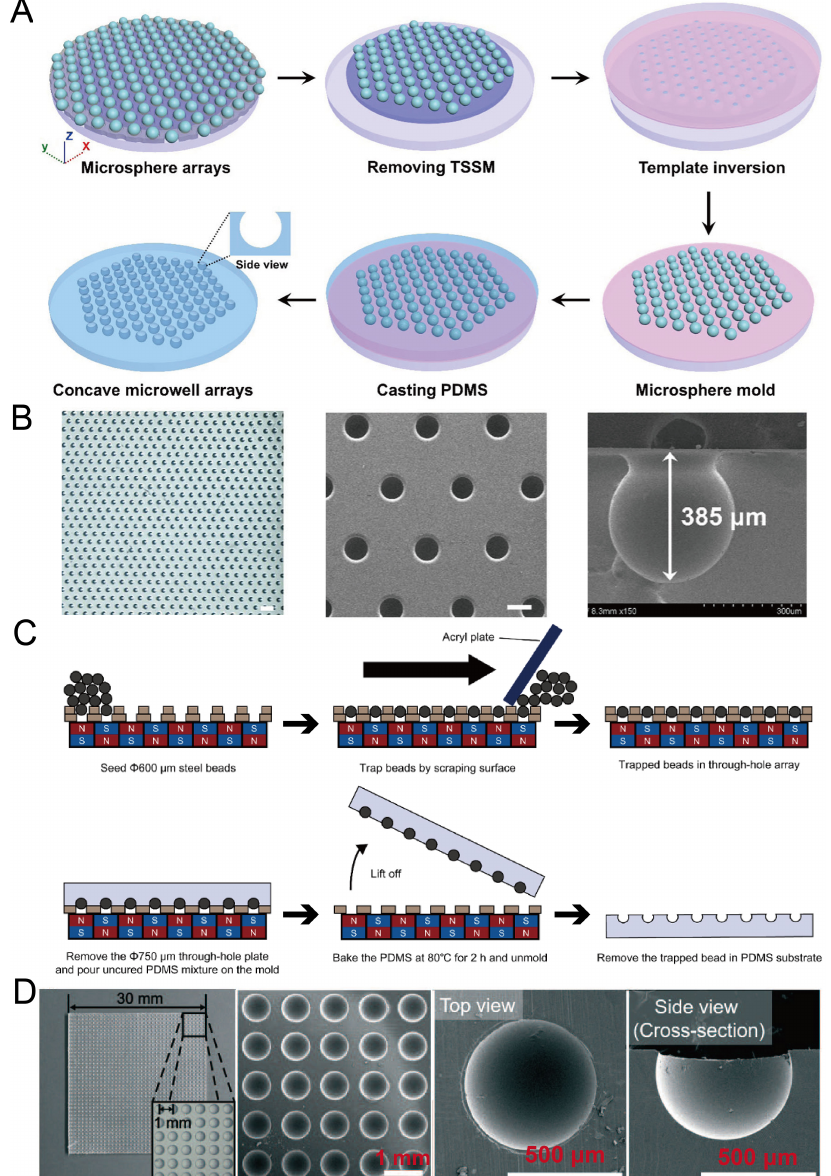
Figure 7. Replica molding of micro-beads. ( A ) At first, a microsphere array was formed on a glass plate utilizing a through-hole stainless steel mesh and dual adhesive tape; then, it was used for the replica molding of PDMS [63]. ( B ) A picture of a PDMS piece with concave microwells (left), an SEM picture of concave microwells (middle), and an SEM picture of a single microwell (right) [63]. The scale bar in the left picture is 1500 µm, and scale bar in the middle picture is 300 µm. Reprinted (adapted) from [63]. Copyright (2020) with permission from John Wiley and Sons. ( C ) At first, a magnetic bead array was formed using a through-hole plate under a magnetic field. After that, PDMS was poured, cured and lifted from the bead array. After removing the magnetic beads, concave microwells were ready on PDMS [65]. ( D ) Pictures of concave microwells in different magnifications prepared by the method illustrated in ( C ) [64]. Reprinted (adapted) from [64]. Copyright (2016) with permission from Royal Society of